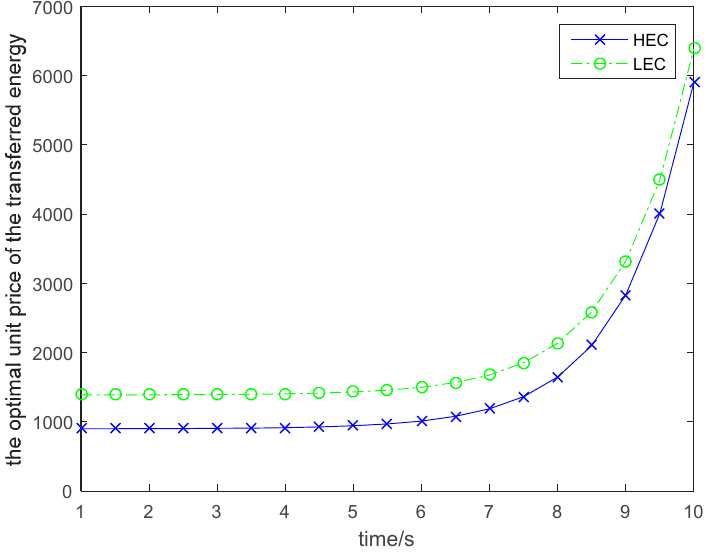
Sensors 2019 , 19 , x FOR PEER REVIEW Figure 4. Power level for wireless energy transfer with different discount rates. Figure 4. Power level for wireless energy transfer with di ff erent discount rates.